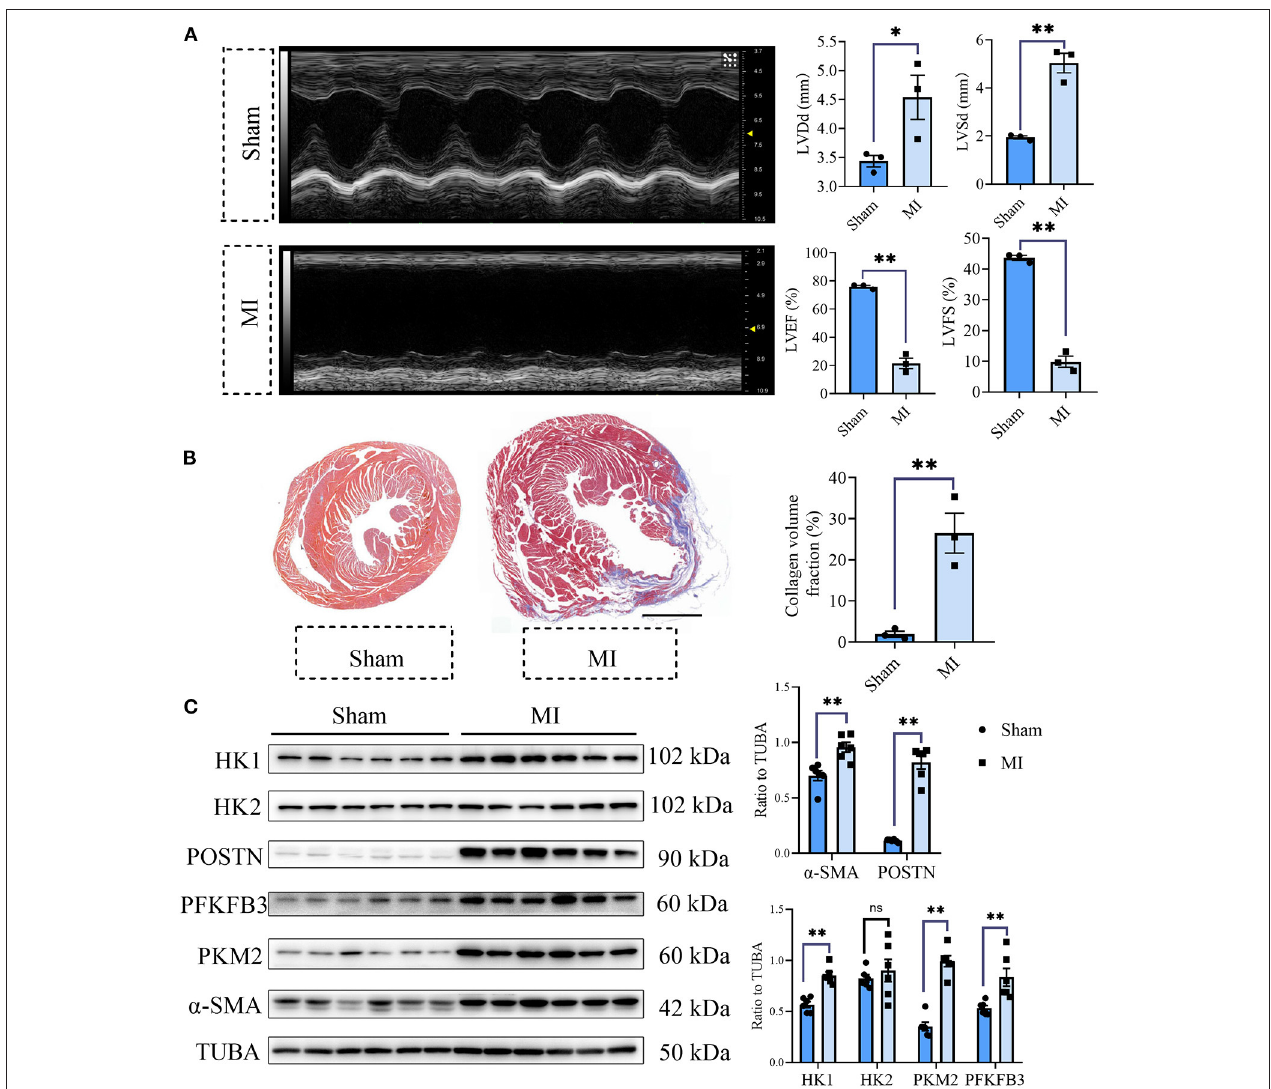
FIGURE 1 | Cardiac fibrosis was accompanied by enhanced glycolysis in MI mice. (A) The cardiac function measured by echocardiography was shown. Representative images of the M-mode of the echocardiography results, and the related parameters (LVEF, LVFS, LVDd, LVSd) measurement were displayed, respectively. (B) Masson staining of the heart harvested on the 28th day after the MI or sham surgery. Representative images (left) and the statistical analysis (right) were shown. (C) Western blot of the expressions of glycolytic and CF activation markers between the MI and sham mice. The representative image (left) and the statistical analysis (right) were shown. LVEF, left ventricular ejection fraction; LVFS, left ventricular fractional shortening; LVDd, left ventricular end diastolic dimension; LVSd, left ventricular end systolic diameter; MI, myocardial infarction; Sham, sham operation; HK1, hexokinase 1; PFKFB3, 6-phosphofructo-2-kinase/fructose-2, 6-bisphosphatase 3; PKM2, pyruvate kinase isoform M2; POSTN, periostin; α -SMA, Alpha smooth muscle actin; n = 3 in (A,B) ; n = 6 in (C) ; * P < 0.05; ** P < 0.01; ns, no significance. Scale bar = 1000 µ